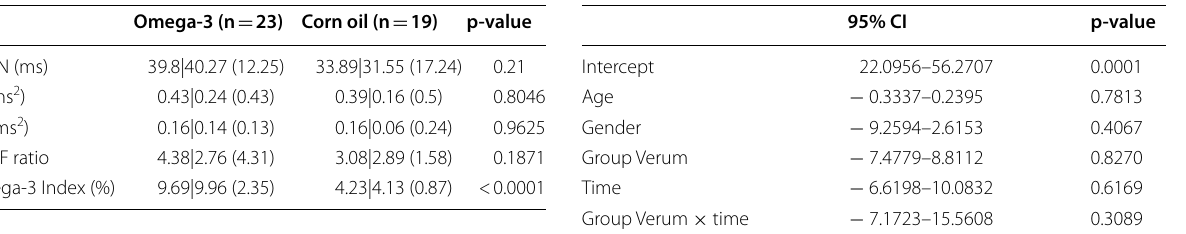
Table 5 Endpoint values: mean/median (SD)